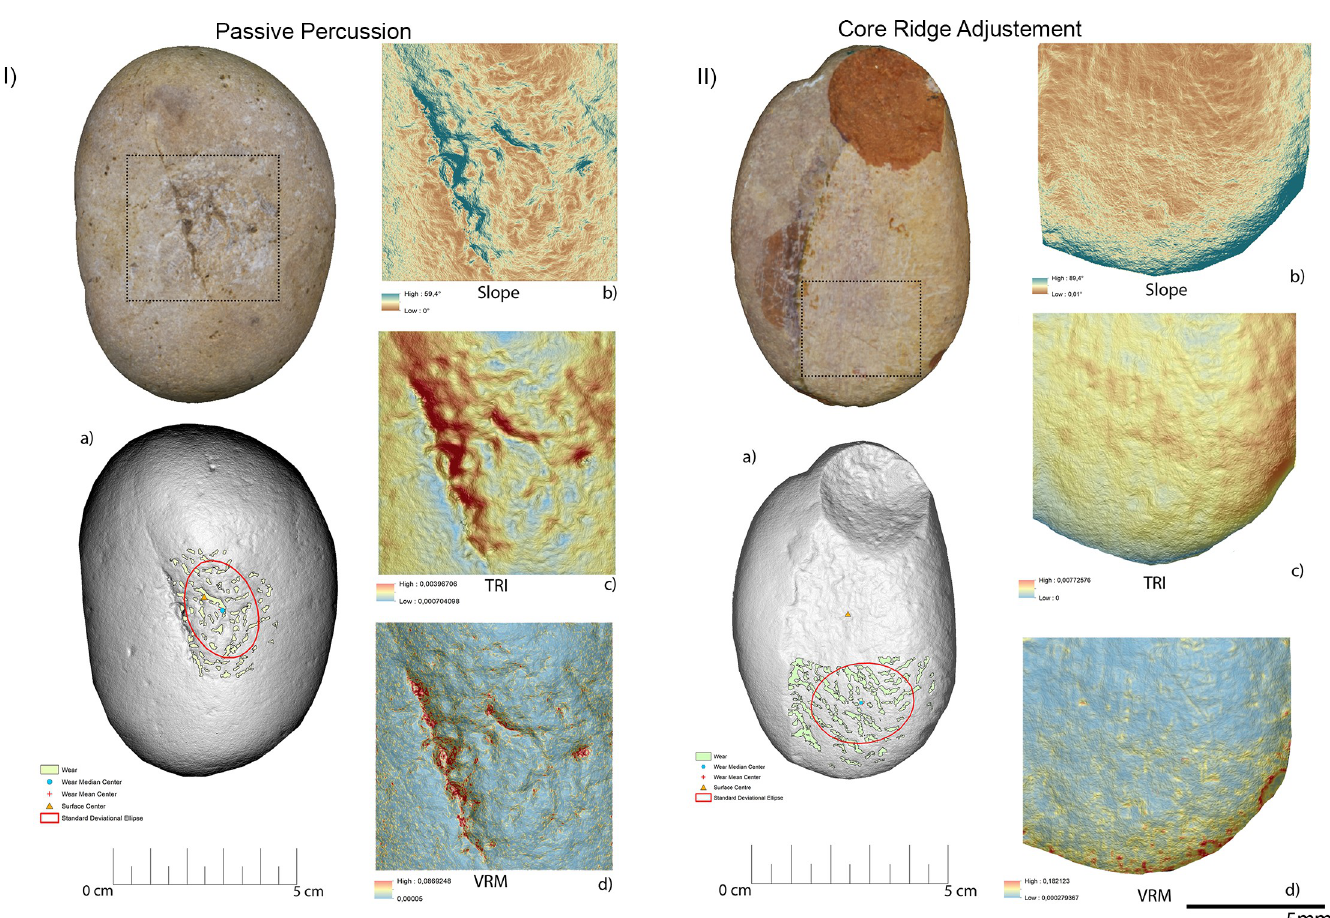
Fig 16. Experimental object utilized in passive percussion (I) and core ridge adjustment (II). (a) Spatial distribution of the identified wear; (b) slope; (c) terrain roughness index; (d) vector roughness